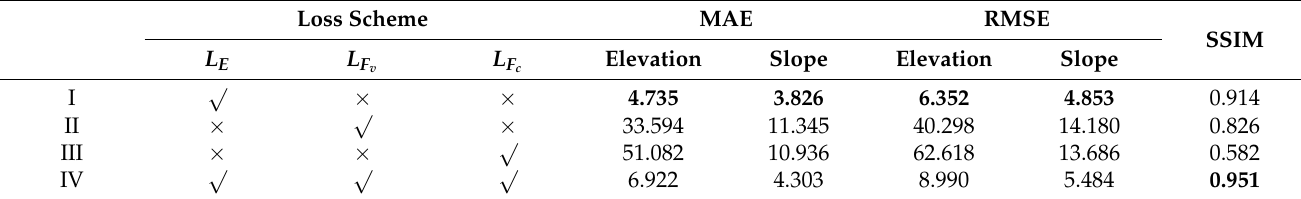
Table 3. The accuracy indicators of different loss schemes.